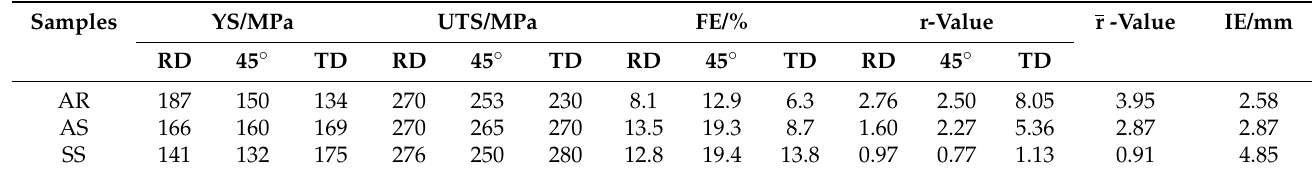
Figure 12. Mechanical behavior: ( a , d ) as-received sample, ( b , e ) the sample after annealing, and ( c , f ) the sample after bending and straightening. Table 1. Mechanical properties of various samples.